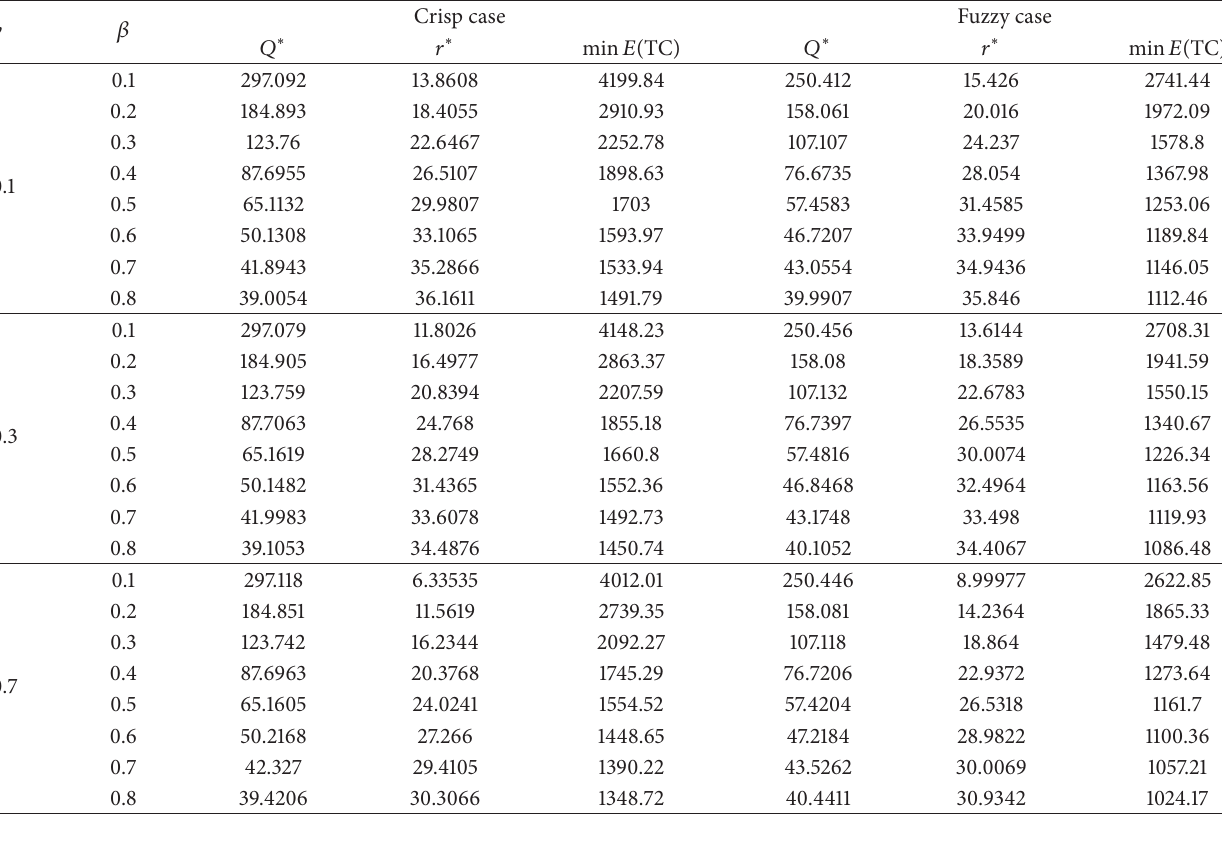
Table 1: The exact solutions and min 𝐸 (TC) for model (I) and model (I f ) at Exponential distribution.